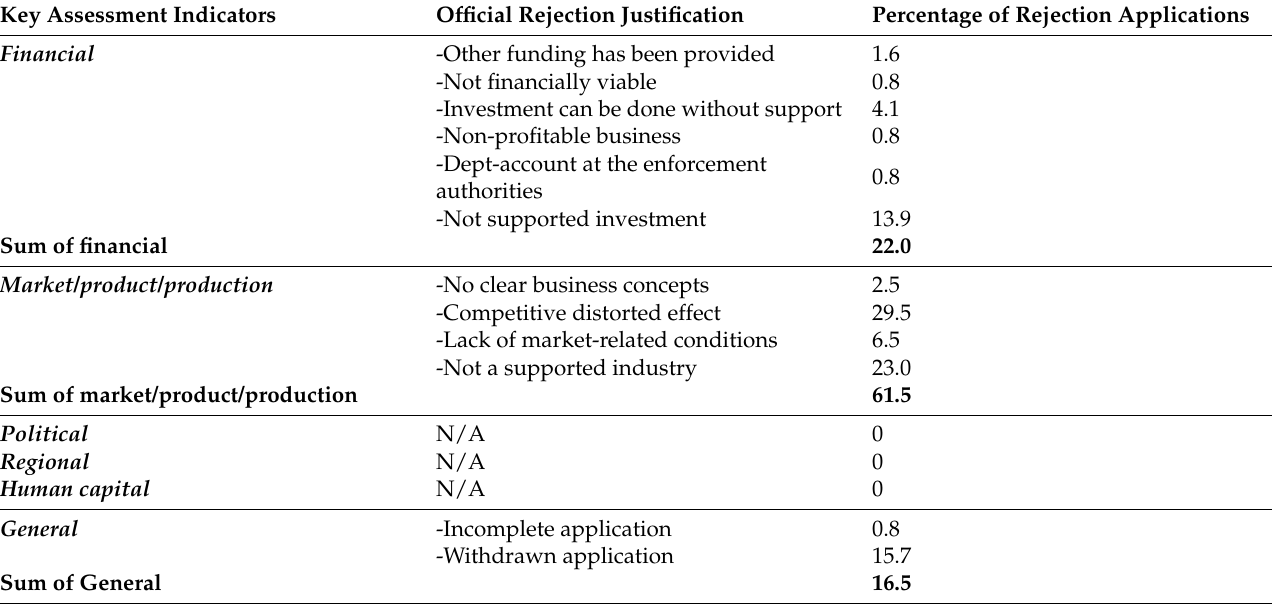
Table 3. Official justifications for rejection